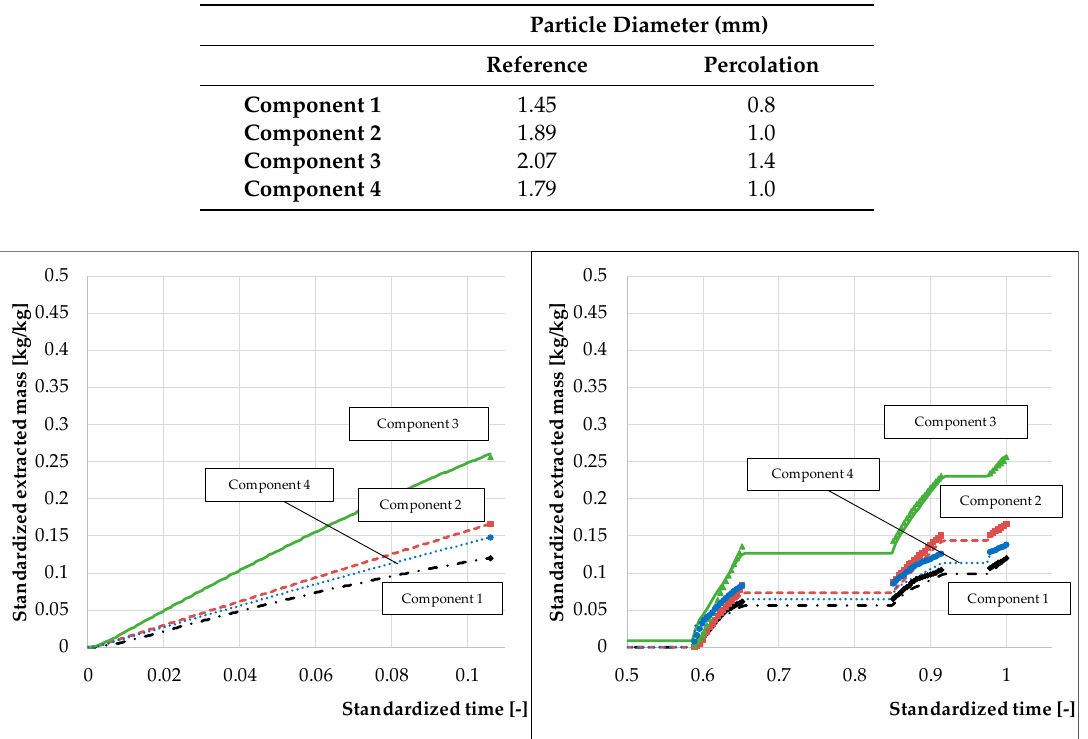
Table 2. Overview of particle sizes in the reference process and the single step percolation.